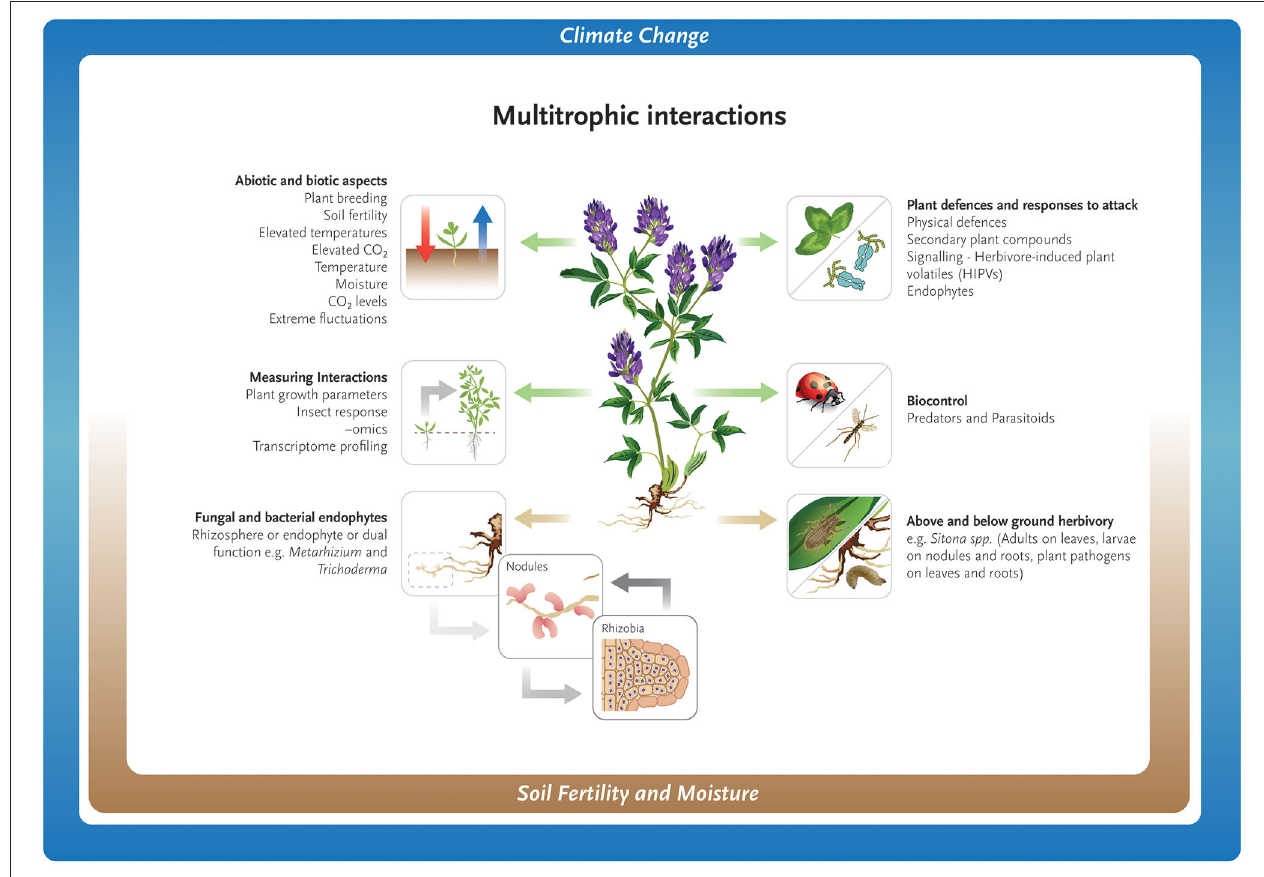
FIGURE 1 | Abiotic and biotic challenges for the growth and maintenance of Medicago sativa as a forage